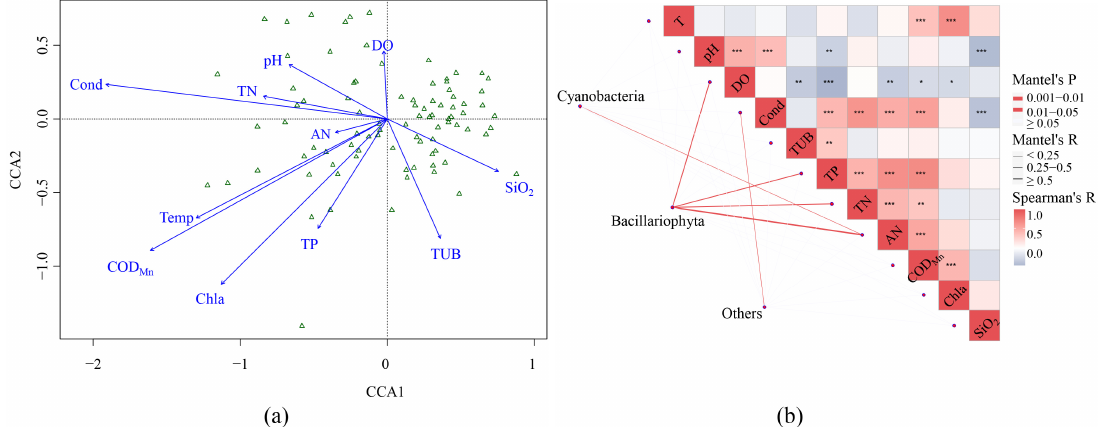
Figure 5. CCA and Mantel test showed the relationship of periphytic algae community and environ- ment variable in all inflow river. ( a ) CCA; ( b ) Mantel test.